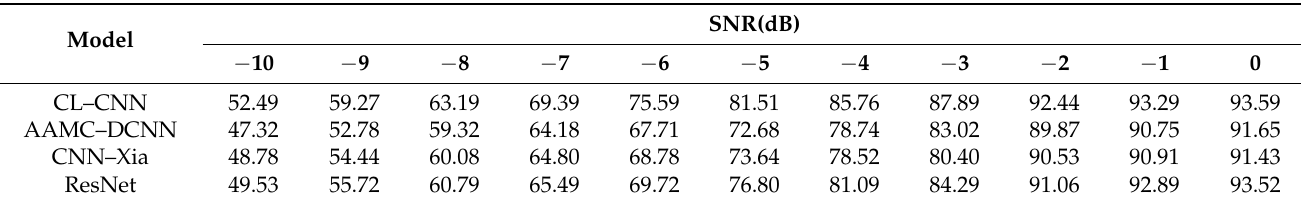
Table 13. Generalization ability test with the sample size for each class being 55.